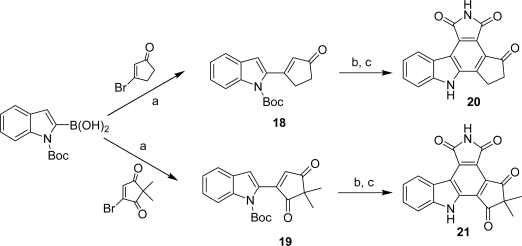
(a) Pd(PPh3)4, benzene, EtOH, Na2CO3.(c) maleimide, toluene, sealed tube, 3 days. (c) DDQ, dioxane, rt, 48 h.